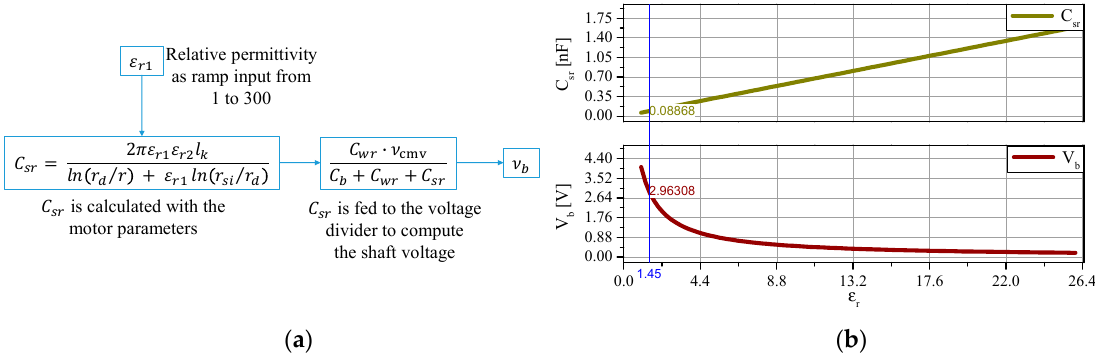
Figure 6. ( a ) Block diagram of the simulation. ( b ) Increase in capacitance C sr and decrease in shaft voltage V b with respect to relative permittivity ε r 1 .